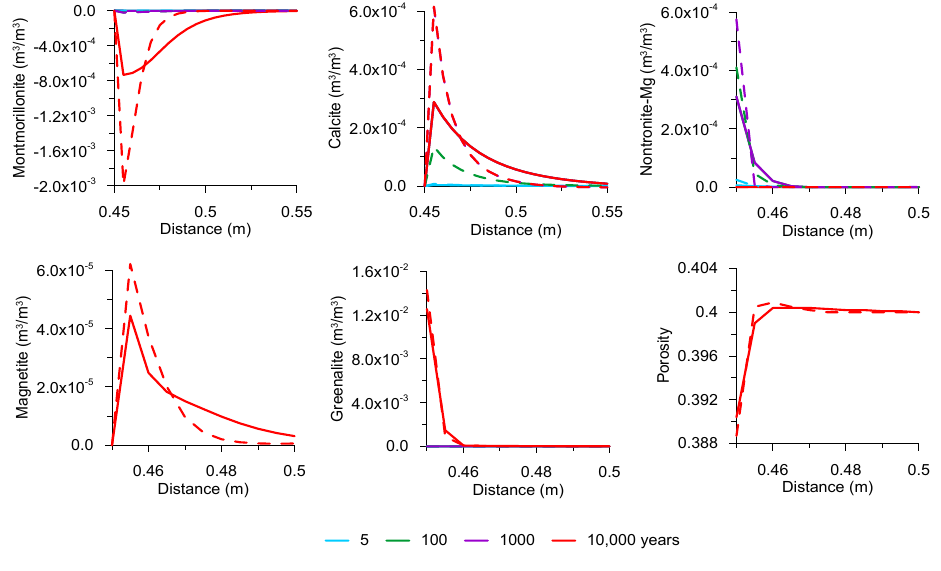
Figure 7. Results of the numerical model with a diffusion coefficient of 6 × 10 − 10 m 2 s − 1 (r c = 2 µ m y − 1 ) (continuous line) are compared with those from the reference model (dashed line). Volumetric fraction of minerals and porosity versus distance. For the primary phases (montmoril- lonite and calcite) the variation of the volumetric fraction is plotted. Positive values mean precipita- tion and negative values mean dissolution. The interface between steel and bentonite is at 0.45 m. Results at 5, 100, 1000 and 10,000 years of interaction are compared. For magnetite and porosity only results at 10,000 years are